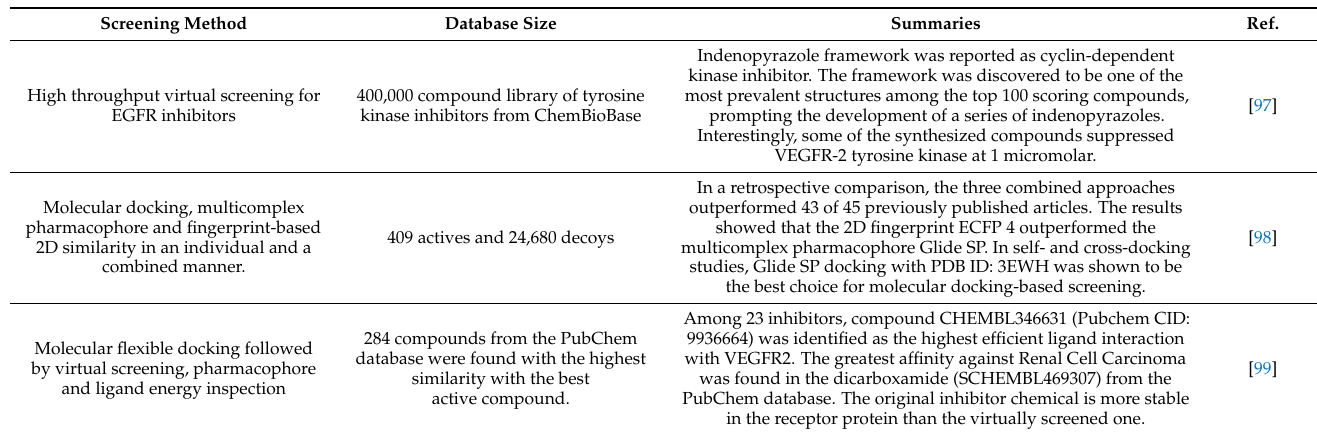
Table 3. Summaries of high throughput virtual screening that aim at finding hits against vascular endothelial growth factor